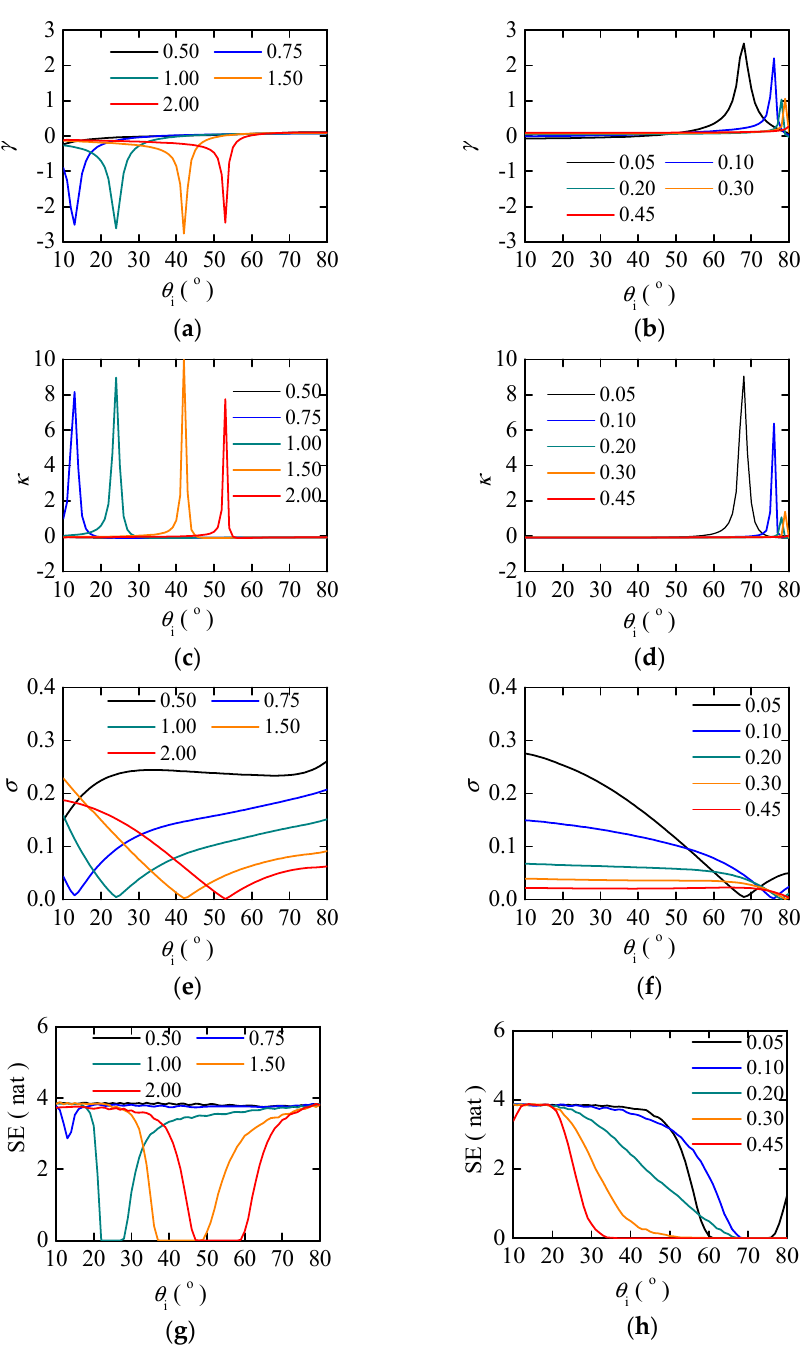
Figure 7. Distribution response and corresponding SE as a function of incident angles for varying: ( a , c , d , g ) ks . kl = 5.0, m v = 0.2 m 3 m − 3 ; and ( b , d , f , h ) m v . ks = 1.0, kl = 5.0; and ( a , b ) γ ; ( c , d ) κ ; ( e , f ) σ ; and ( g , H ) SE. Normally distributed inputs are the same as those in Figure